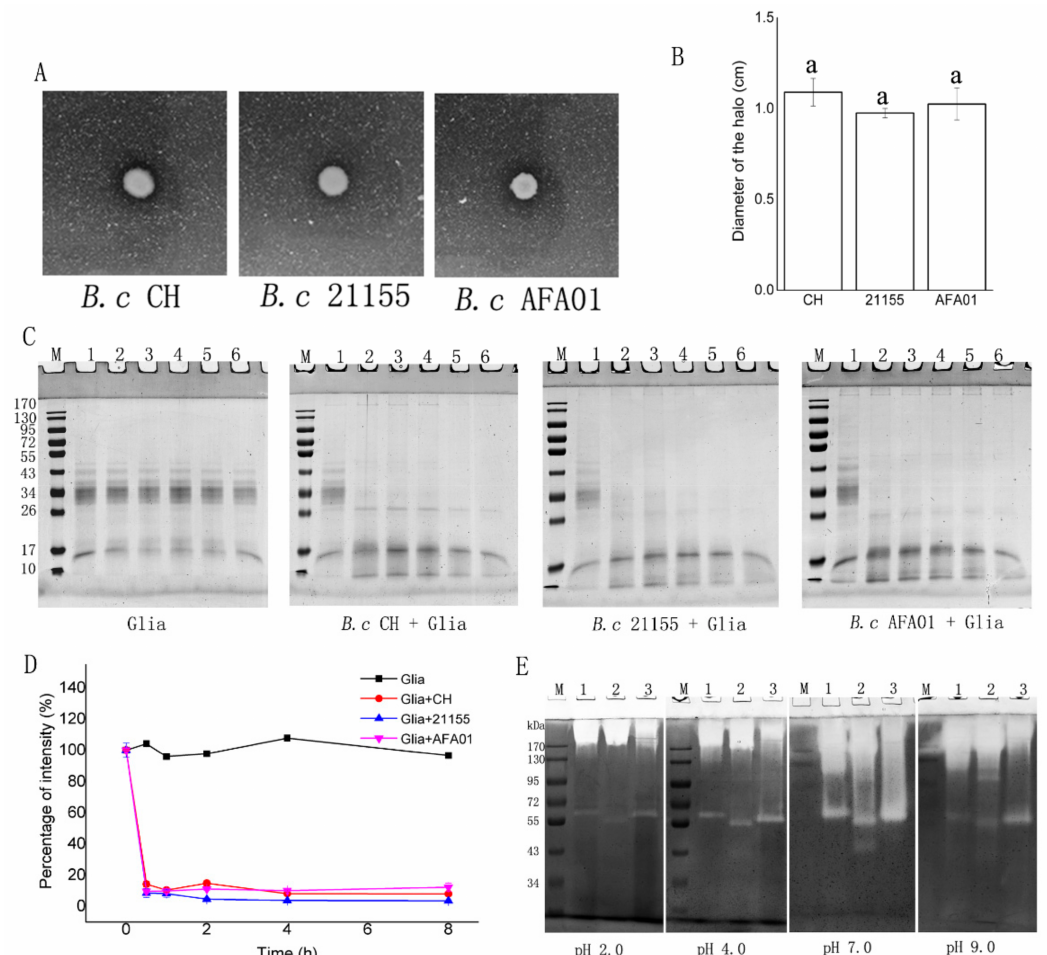
Figure 1. Glutenase activity of the three B. cereus strains. ( A ) Proteolytic zones in gluten agar plates that were inoculated with B. cereus. ( B ) The diameter of the halo formed in the gluten agar plates. The statistics are presented by the labels of ‘a’, which indicate non-significant ( p > 0.05) differences. Columns represent the means ± SD. ( C ) The SDS-PAGE patterns of gliadin degradation in solution by the three B. cereus strains. Cells suspended to an OD 620 1.2. Mixed gliadins were added to a final gliadin concentration of 250 µ g/mL. After t = 0, 0.5, 1, 2, 4 and 8 h incubation at 37 ◦ C, aliquots of 100 µ L were removed, heat-inactivated, and analyzed by 10% SDS-PAGE. M: molecular weight marker, Lane 1–6: bacteria + gliadin mixtures incubated for t = 0, 0.5, 1, 2, 4 and 8 h, respectively. ( D ) The percentage of 34–43 kDa protein bands in the gels was calculated by using Quantity One software (Bio-Rad). The data are presented as the means ± SD. ( E ) Gliadin zymography of three B. cereus strains at pH 2, 4, 7 and 9: 150 µ L aliquots of cells (OD 620 5.0) were applied per lane. M: molecular weight marker, Lane 1: B. cereus CH; lane 2: B. cereus 21155; lane 3: B. cereus